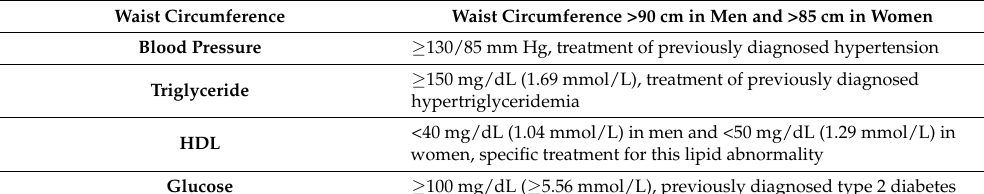
Table 1. Diagnostic criteria for the clinical diagnosis of metabolic